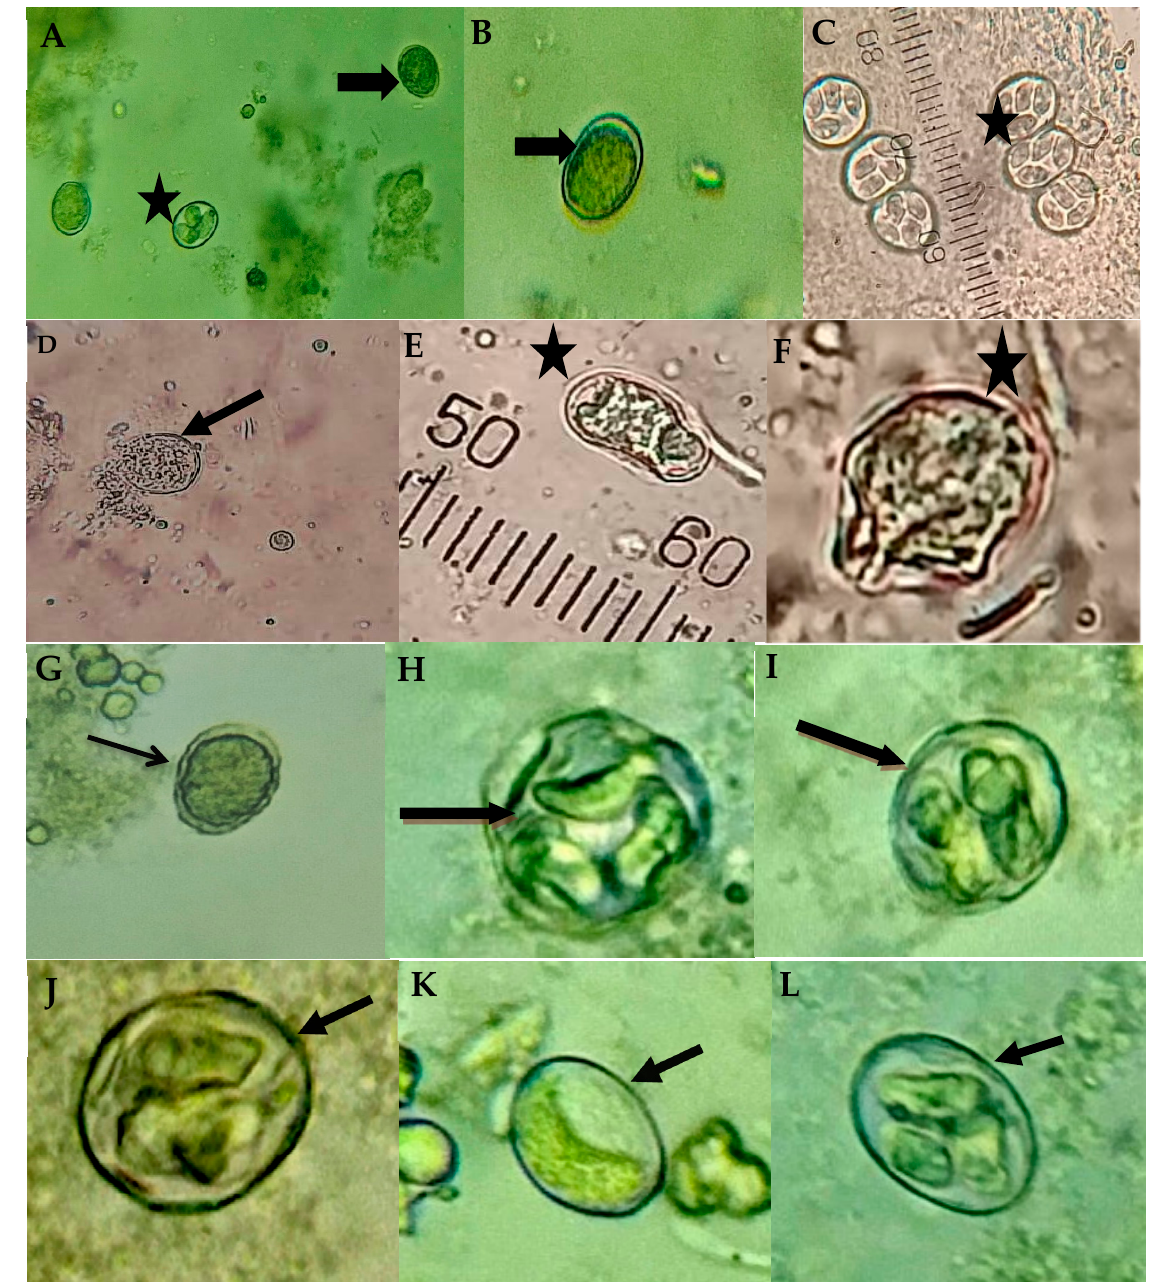
Figure 2. The morphological changes of Eimeria tenella oocysts after 24 and 48 h due to in vitro exposure to various treatments. Non-treated control: ( A , B ) Non-sporulated (thick black arrow) oocysts with regular, smooth double walls and refractile contents. ( C ) Sporulated tetrasporic dizoic oocysts (black star). Allicin-treated oocysts: ( D ) Non- oocysts were severely deformed with a ruptured wall and leaked contents (thick black arrow). ( E , F ) Some oocysts exhibited a shrunken appearance, lost their regular ovoid shape (black star), and contained undifferentiated contents. Alcoholic garlic extract treated oocysts: ( G ) The oocyst wall was corrugated (thin arrow), ( H , I ) The contents of the oocyst were disrupted (thick black arrow). Oocysts were treated with 5% KOH; ( J – L ) The oocysts’ walls were relatively undisturbed (thick black arrow), but the cyst contents were deformed. Light microscope, 40 × and 100 ×